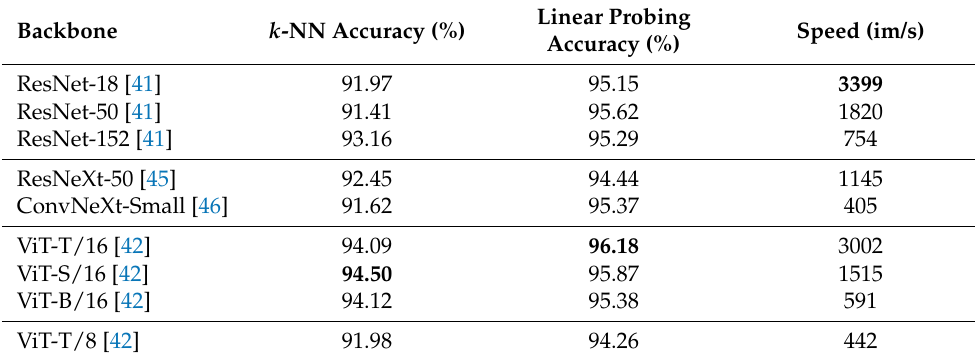
Table 10. Comparison of different backbones. We report accuracy under k -NN and linear probing. The inference speed was tested on one NVIDIA Titan V GPU with mixed precision enabled. Backbone